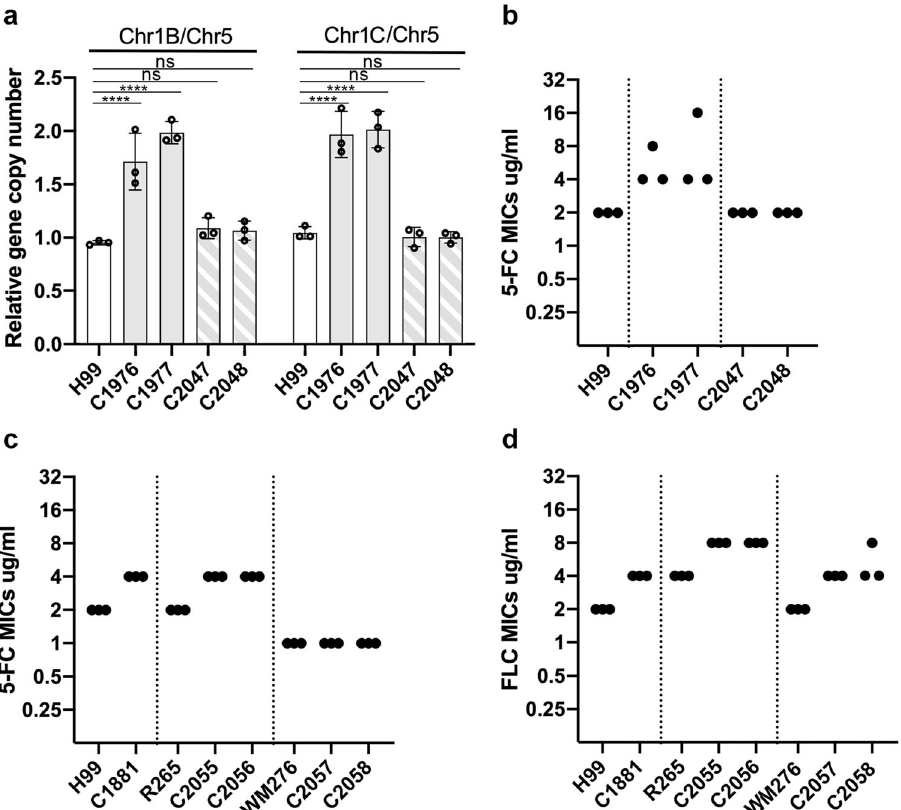
Fig. 3 Chr1 duplication and extra copy of AFR1 affects the 5-FC resistance levels. a Relative copy number of genes resided on chr1. Probes speci fi c for the genes resided on the left or right arms of chr1 (Chr1B or Chr1C) were chosen to assess the changes in chr1 copy number. The PCR results of the chr1- speci fi c probes were compared to that of chr5, which served as unduplicated internal control in the indicated strains. Data are presented as mean values ± standard deviation from three biological repeats of each strain. Two-way ANOVA with Tukey ’ s test for multiple comparisons (ns = not signi fi cant, **** = p < 0.0001). b Broth 5-FC MIC of the strains containing duplicated chr1 and the strains after repeated transfers which lost the duplicated chr1. c Broth 5-FC MIC of the strains containing extra copies of AFR1 . d Broth fl uconazole MIC of the strains containing extra copies of AFR1 . The MIC determination was repeated three times for each